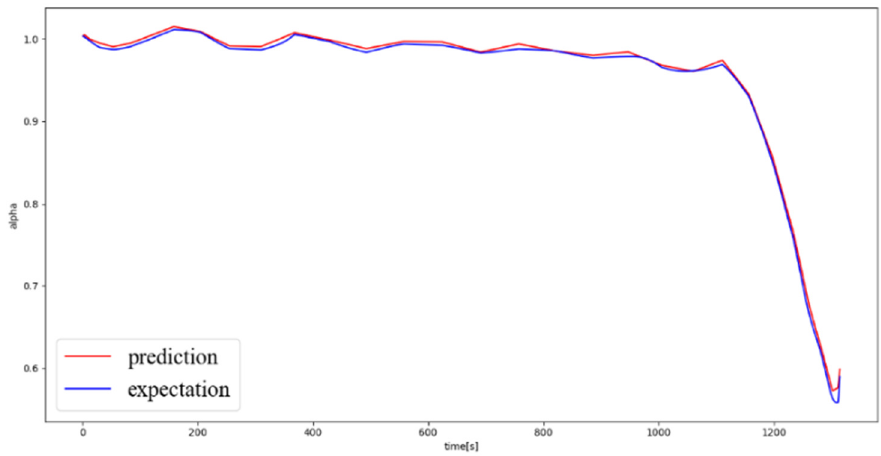
Figure 6. Comparison of the predicted and expected values of the generalized coefficient of the lift.